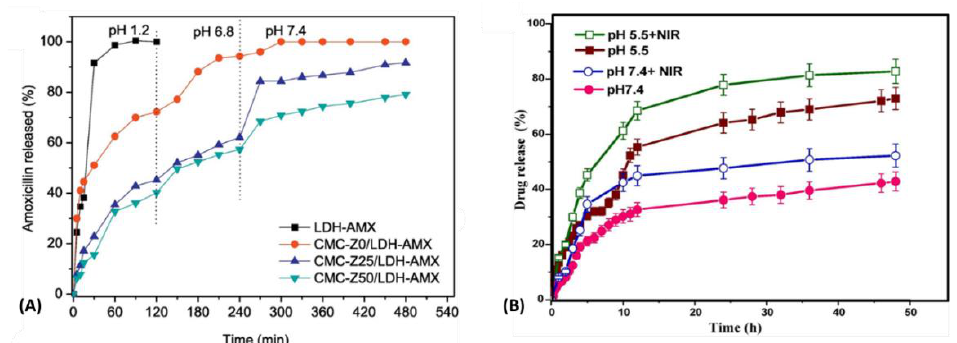
Figure 16. ( A ) Amoxicillin drug release profile at in vitro simulated gastrointestinal conditions (2 h at pH 1.2, 2 h at pH 6.8 and 4 h at pH 7.4, simulating the gastric juice and the first and second zone of intestinal fluid, respectively) from LDH-amoxicillin and CMC-zein coated LDH-amoxicillin systems (reprinted from Rebitski et al. [229] with permission of Elsevier) and ( B ) Cumulative DOX release profile at pH 5.5 and 7.4 in the absence and presence of NIR radiation from the LDH-based chemophotothermal nanocomposite system (reprinted from Anirudhan and Chithra-Sekhar [230] with permission of Elsevier).